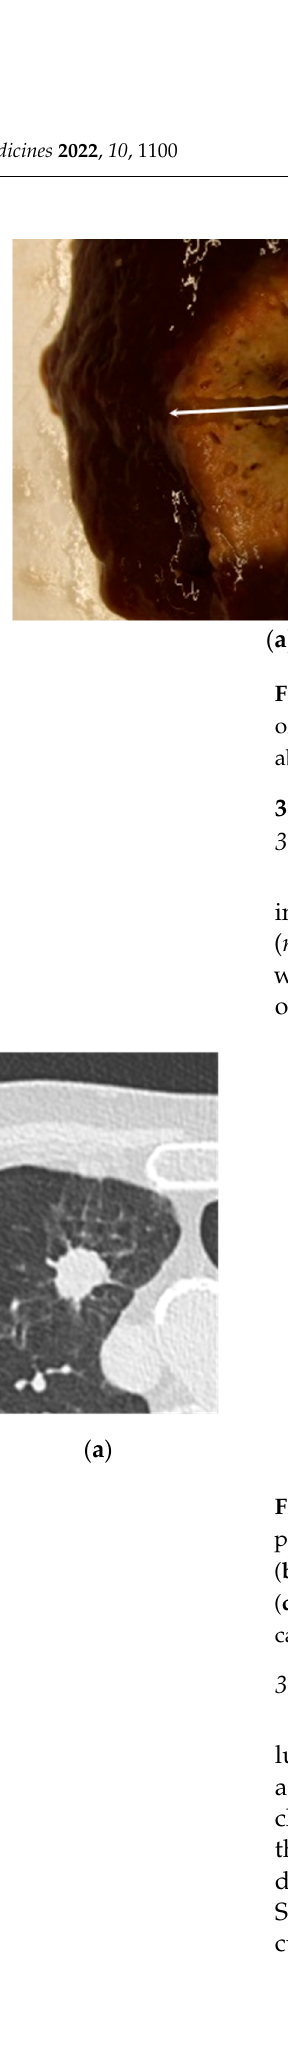
Figure 2. Example of a radio-frequency ablation (RFA) performed percutaneously using a bipolar probe. Displayed are ( a ) CT images before insertion of the RFA probe into the lung tumor mass, ( b ) the formation of necrotic tissue during RFA, ( c ) the formation of necrotic tissue after RFA, and ( d )